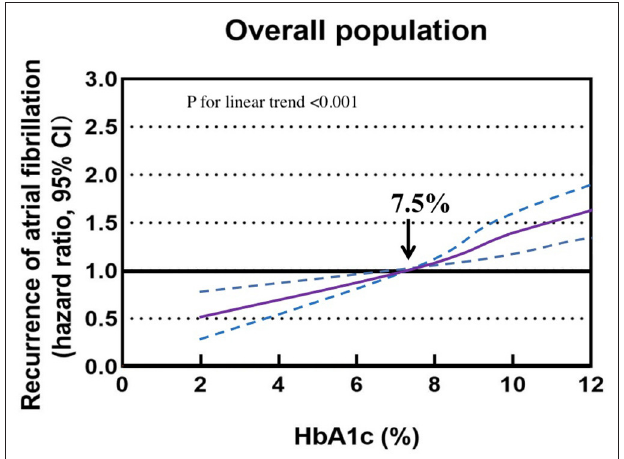
FIGURE 2 | Association of glycated hemoglobin with the recurrence of atrial fibrillation in a restricted cubic spline model. Solid purple lines are multivariable adjusted hazard ratios, with dashed blue lines showing 95% confidence intervals with glycated hemoglobin 6–7.9% as the reference value.